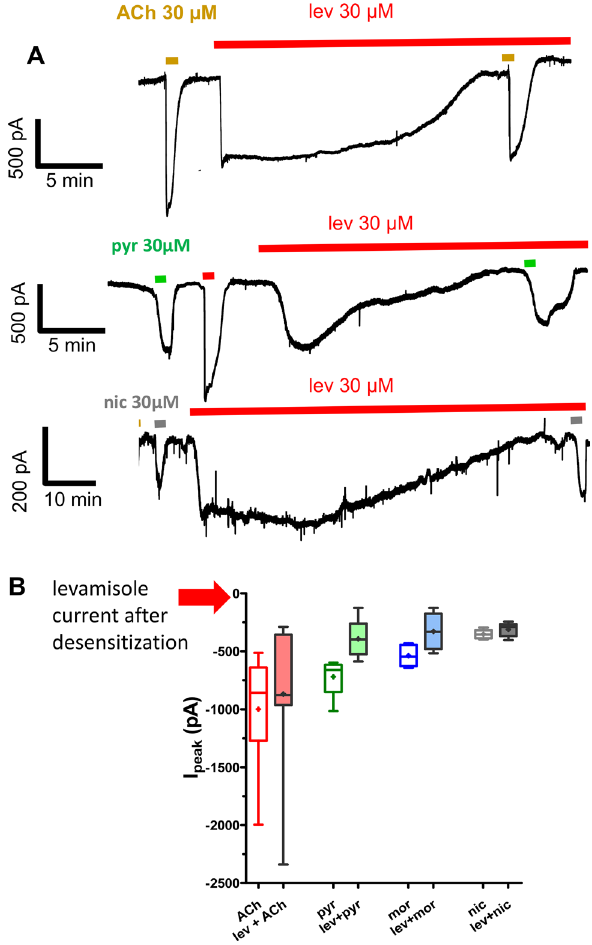
Figure 4. B. malayi muscle cells desensitize to continuous levamisole exposure under whole-cell patch-clamp without losing sensitivity to other nicotinic agonists. ( A ) Representative whole-cell patch-clamp recordings demonstrating cells desensitize with loss of inward current, 15–30 min after continuous application of 30 µM levamisole. Inward currents were observed when the same preparation was exposed to nAChR agonists (30 µM ACh, pyrantel, nicotine and morantel, respectively). ( B ) Bar chart demonstrating inward current before and after levamisole desensitization. Note only pyrantel and morantel showed a significant reduction, paired t- test, n = 5 from 5 different worms, p <